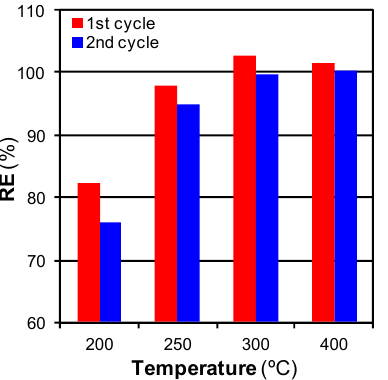
Figure 3. Effect of temperature and the number of adsorption–regeneration cycles on RE (regeneration efficiency).